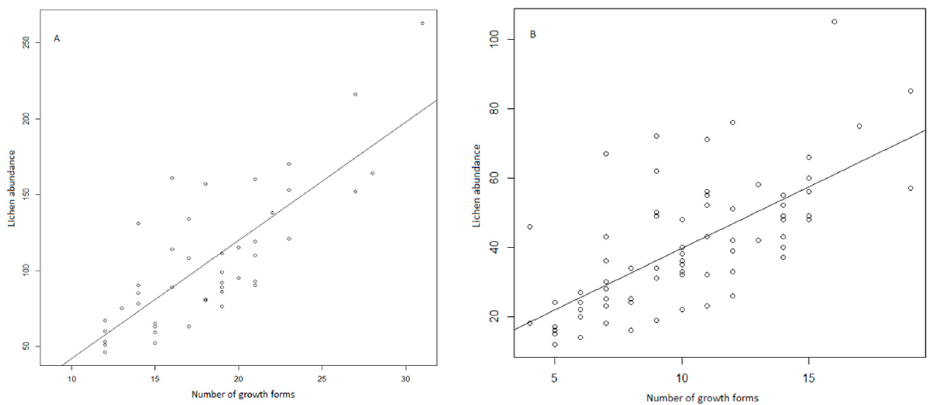
Figure 3. Results of the linear models based on the number of growth forms (x-axis) and epiphytic species abundance (y-axis) in: ( A ) Unmanaged forests (y = 7.291x − 27.868, n = 43, R 2 = 0.695) and ( B ) Managed forests (y = 3.554x + 4.136, n = 76, R 2 = 0.486), where p < 0.0001 in both cases.